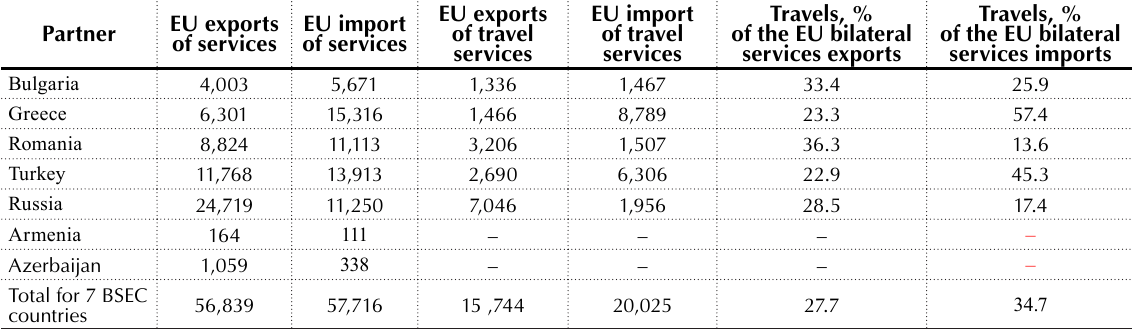
Source: Eurostat and authors’ calculations.